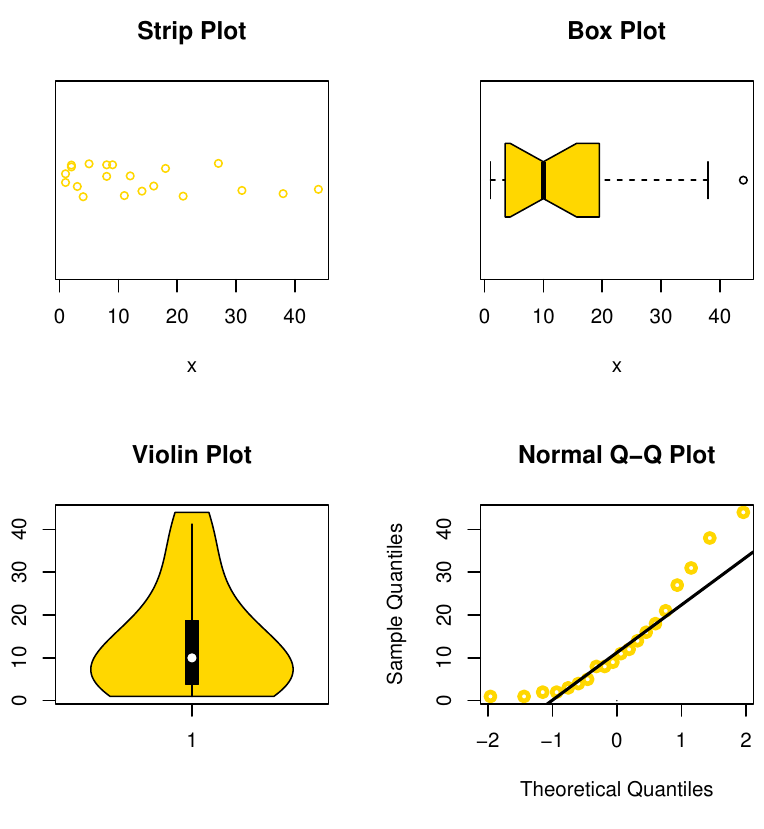
From Table 15, the NDsLE model provided the best fit among all tested models. respectively.